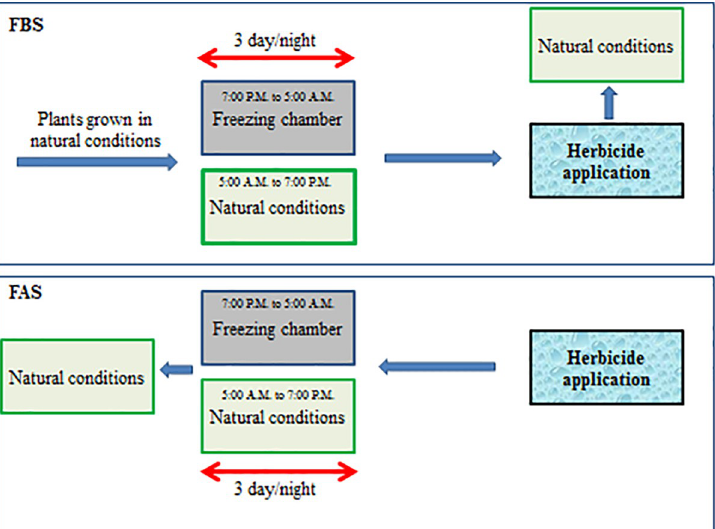
Fig 3. Schematic diagram of the experimental study design. Abbreviation: FBS (freezing before spray); FAS (freezing after spray).